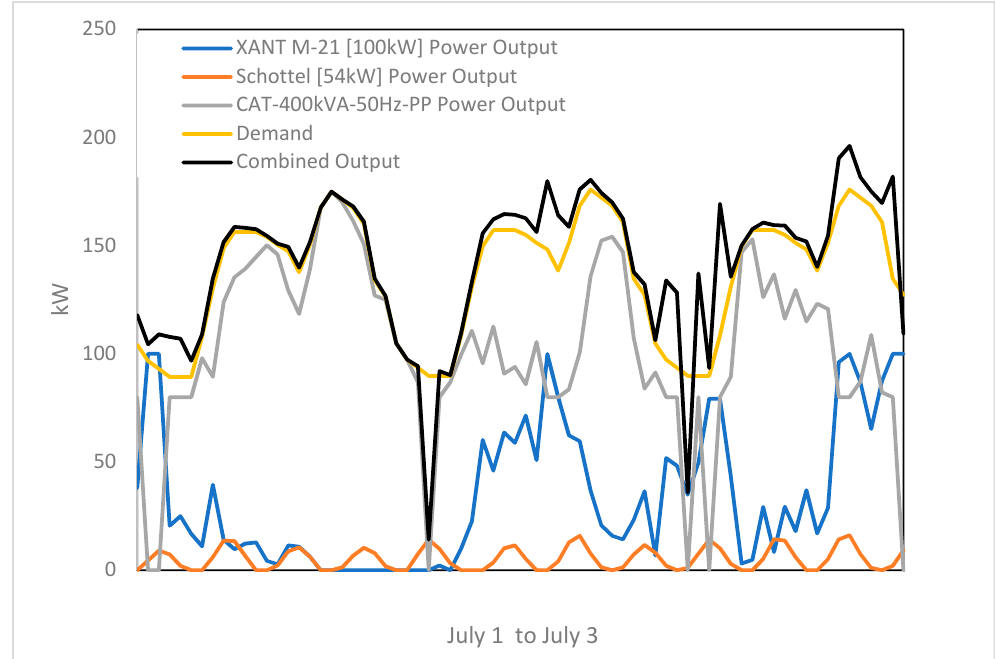
Figure 14. Variation in generated powers and required demand during a three ‐ day period at Foveaux.